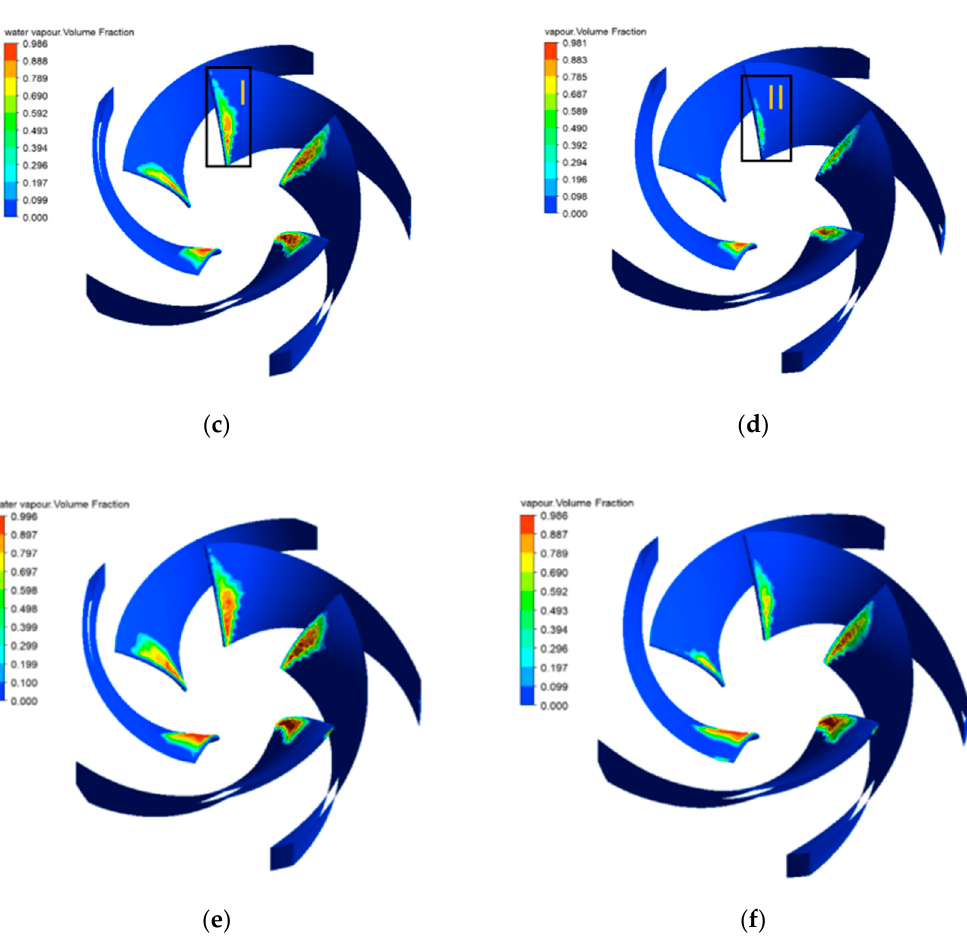
Figure 13. Vapor volume fraction distribution in impeller of original pump and optimal pump at different inlet pressure. ( a ) 60.8 kpa (original); ( b ) 60.8 kpa (optimal); ( c ) 50.7 kpa (original); ( d ) 50.7 kpa (optimal); ( e ) 40.5 kpa (original); ( f ) 40.5 kpa (optimal).